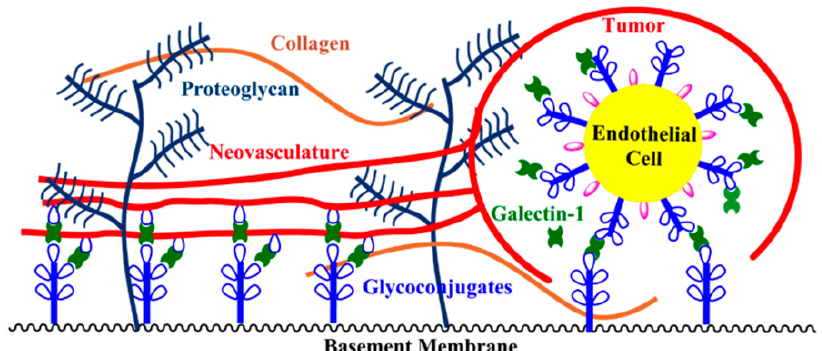
Figure 6. Provision of structural support for neovasculature by galectin-1.